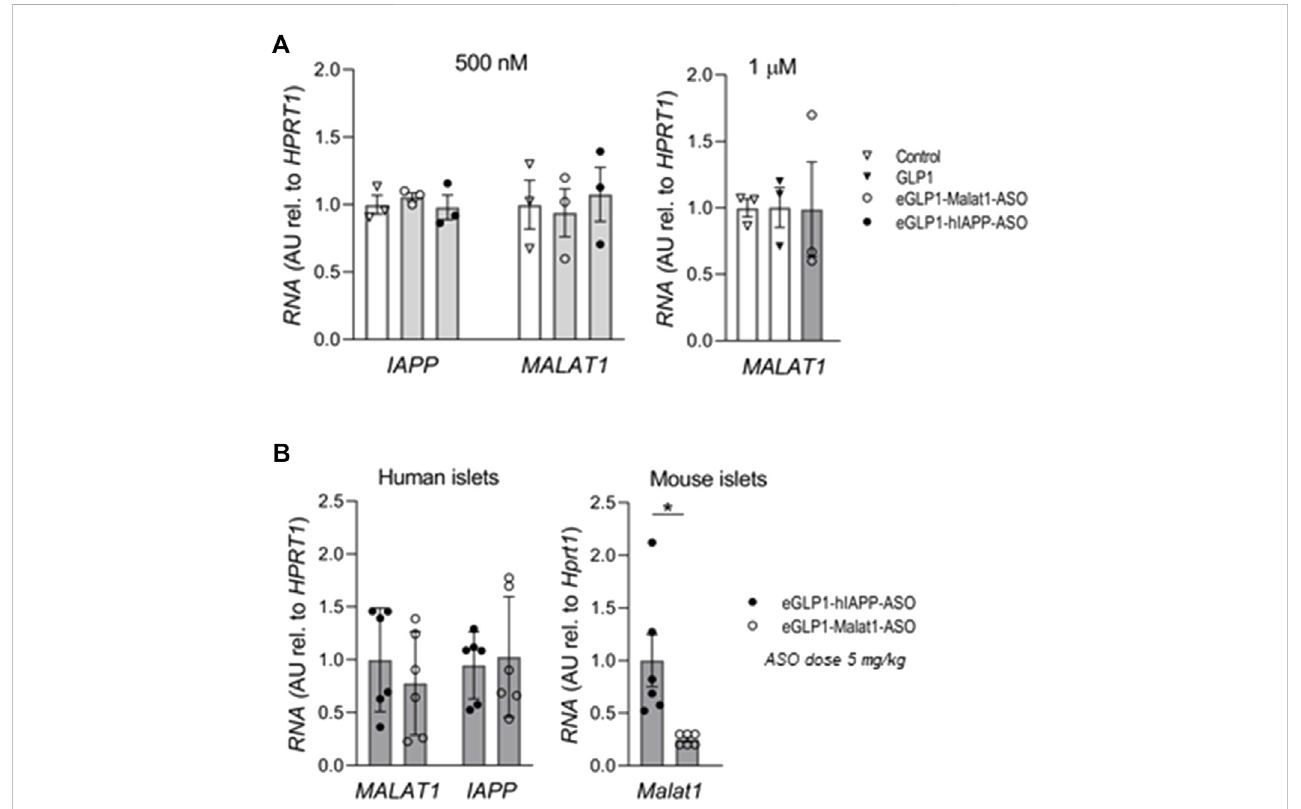
FIGURE 3 The ef fi ciency of eGLP1-ASO is lower in human islets than in mouse islets. (A) Human islets were cultured for 24 h in the presence of 500 nM or 1 μ M of eGLP1-Malat1-ASO, eGLP1-hIAPP-ASO or GLP-1 in two independent experiments performed in triplicates. (B) Scid-Beige mice were transplanted with human islets from a non-diabetic donor and received three weekly injections of ASO at 5 mg/kg. At the end of the experiment, RNA was extracted from the kidney transplants and from the isolated islets from mouse pancreas. Data is mean ± SEM; * p <